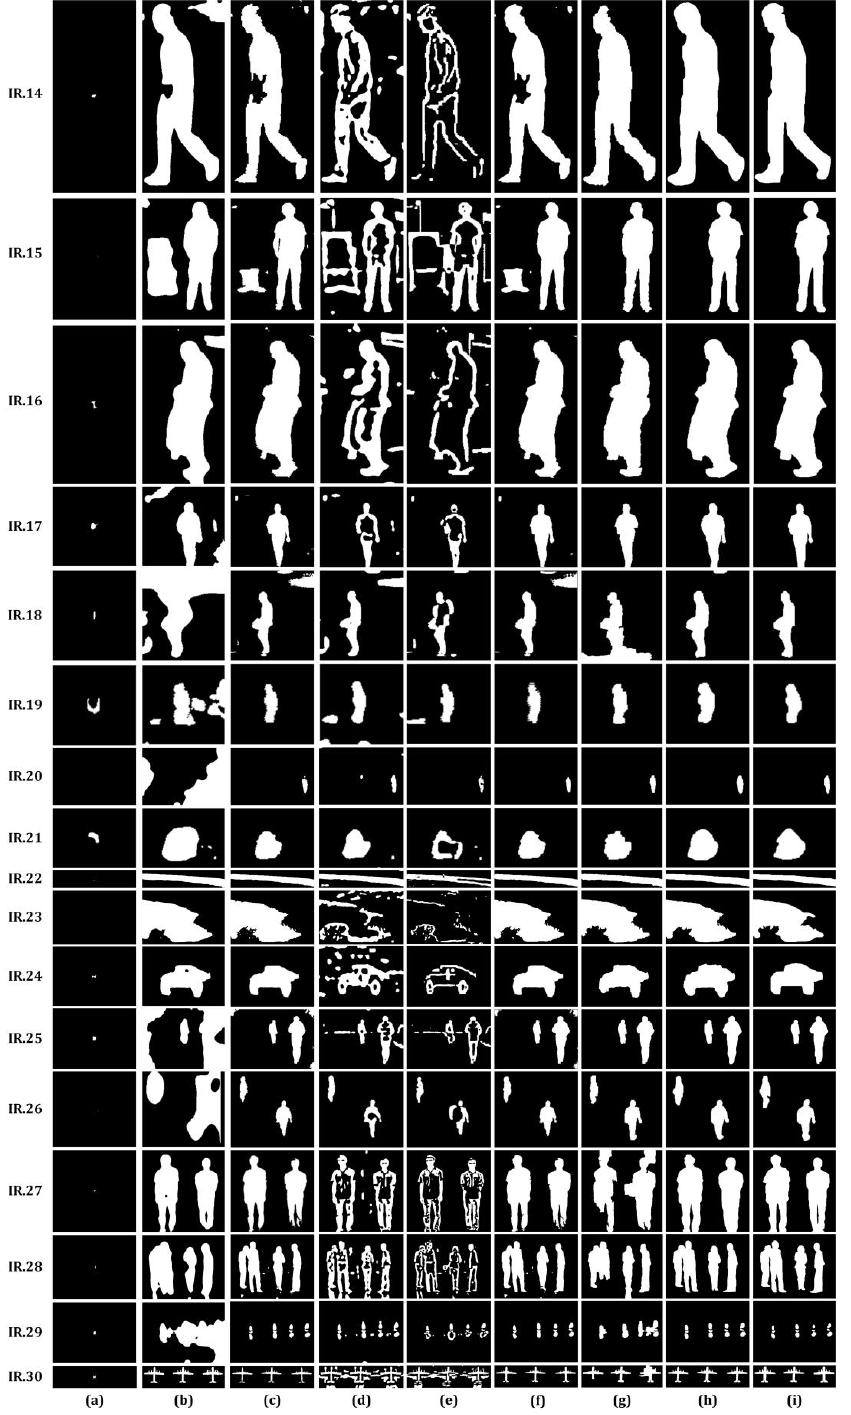
Figure 10. Binary segmentation results of IR image database: ( a ) GAC; ( b ) CV; ( c ) SBGFRLS; ( d ) LBF; ( e ) ILFE; ( f ) Cao’s model; ( g ) MSRM; ( h ) the proposed method; ( i ) ground truth.